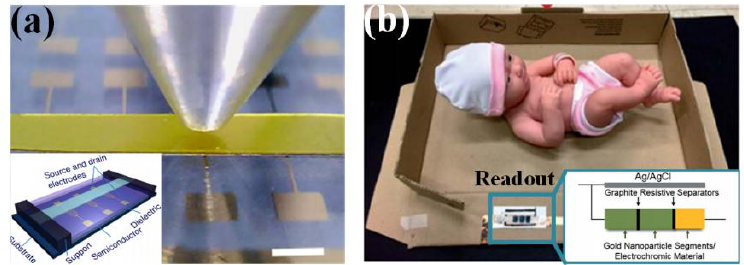
Figure 8. Other working mechanism for wearable sensors; ( a ) FET-based sensor; ( b ) visual sensing mechanism in the balance-in-a-box for infant birth weight determination. Adapted from [136] with permission of The Royal Society of Chemistry.